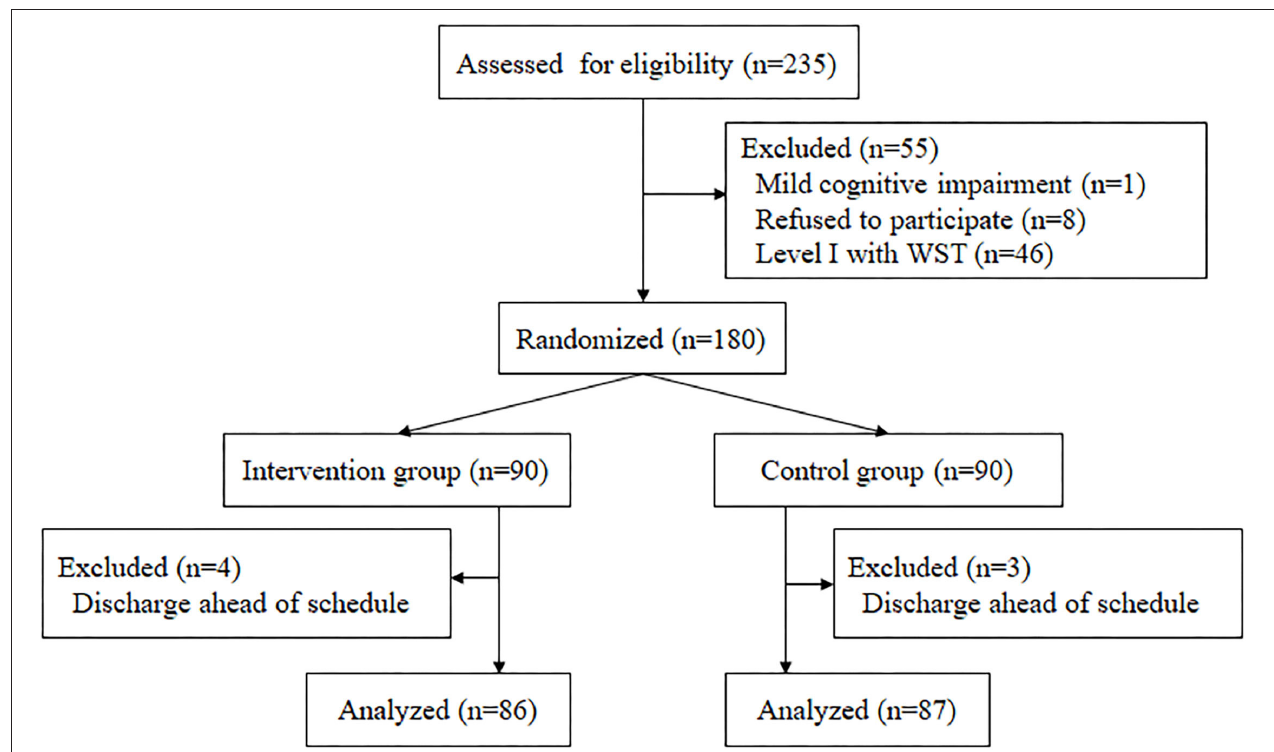
FIGURE 3 | Flow chart of participants included in this study.